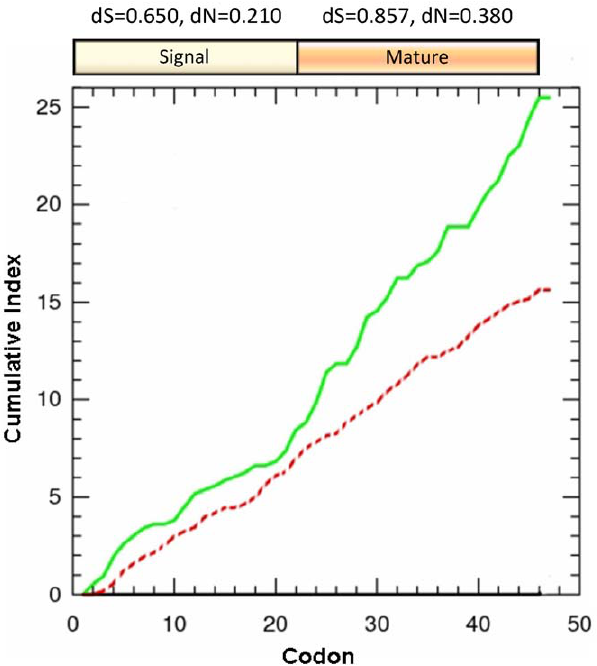
showing that positive selection is contributing for the accelerated rate of amino acid substitutions in the coding regions of other fish antimicrobial peptides, including hepcidin [29] and pleurocidin [30]. Unfortunately, the positively selected sites in pleurocidin were not identified. In this study, the Bayesian approach in model M3 revealed three positively selected sites at positions 25 (p = 0.97,